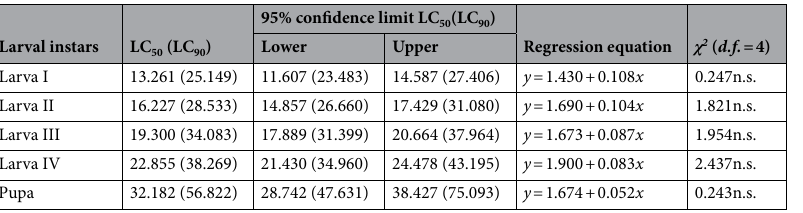
Table 2. Larval and pupal toxicity of AgNP synthesized from sardine fish scales against Anopheles stephensi. No mortality was observed in the control. LC 50 : lethal concentration was killing half of the treated organisms, LC 90 : lethal concentration was killing 90% of the treated organisms, χ 2 : Value of the chi-square, d.f. : degree of freedom, n.s.: non-significant (α =